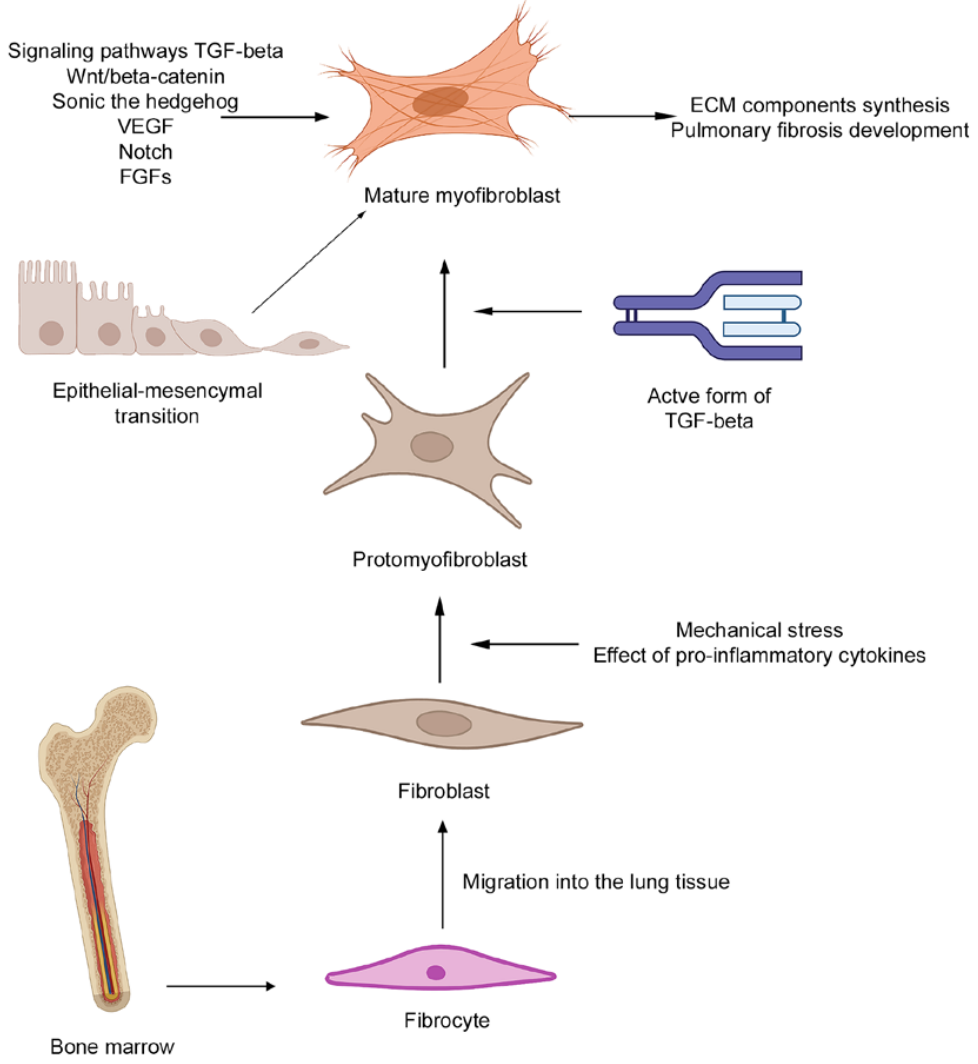
Figure 2. Evolution of fibrocyte to myofibroblast—main effector cell in pulmonary fibrosis devel- opment.